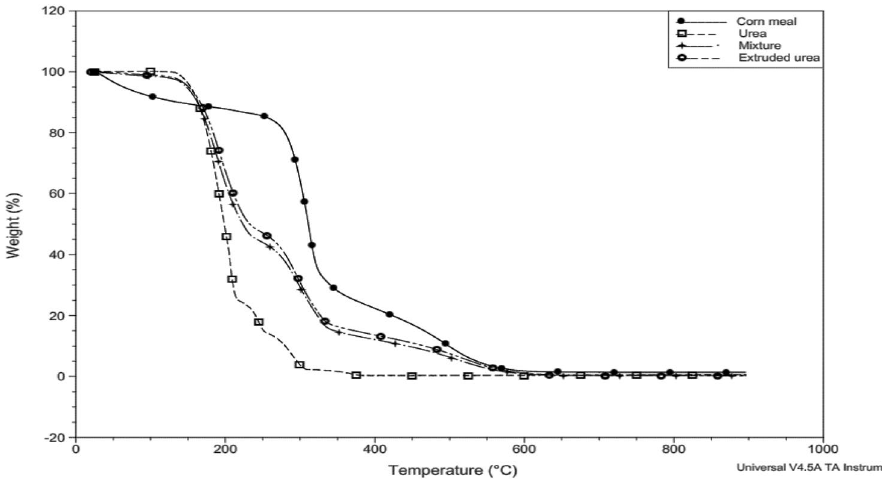
Figure 3. Overlapping TG curves of urea, ground corn, mix corn and urea, and extruded urea.